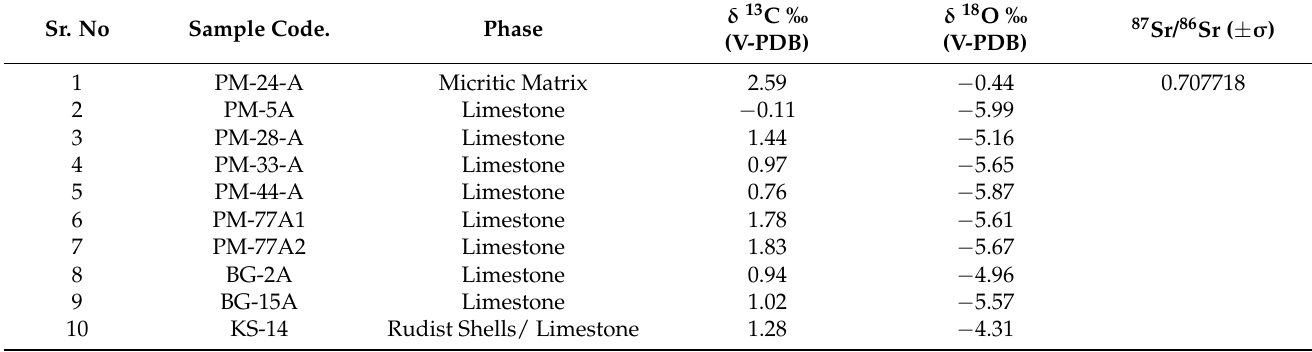
Table 2. Stable ( δ 18 O and δ 13 C) and radiogenic 87 Sr/ 86 Sr isotope data of the studied Samana Suk